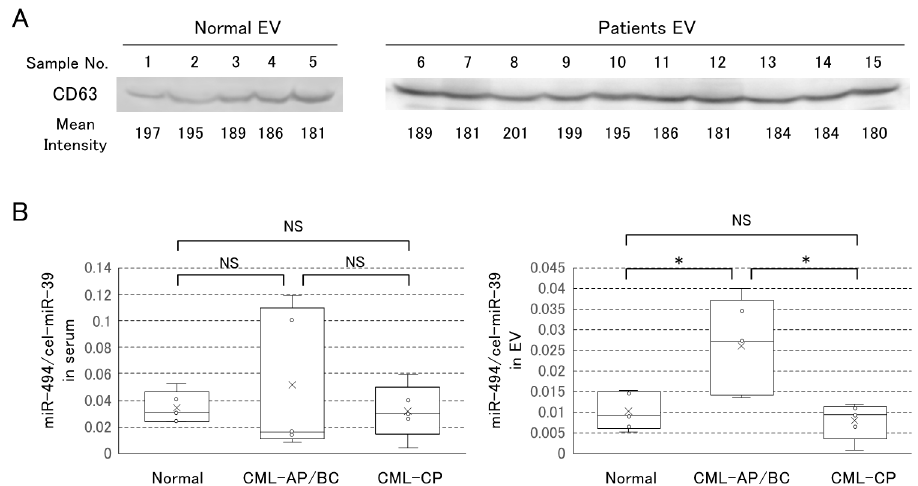
Figure 4. The analysis of EV in serum. ( A ) The EVs from serum were recovered by ExoQuick ® reagent and quantified by western blotting of CD63 protein. Sample number indicate; 1–5 (Normal), 6–10 (CML-AP/BC), 11–15 (CML-CP). The mean intensity of each band is shown below the bands. ( B ) qRT-PCR analysis of miR-494. The black line in each box plot indicates the median. The lower and upper edges of the box indicate the 25% and 75% distribution percentiles, respectively. ( B ) shows in whole serum (left panel) and in only EVs (right panel). Asterisks indicate statistical significance and NS means “Not Significant” (* p < 0.05).